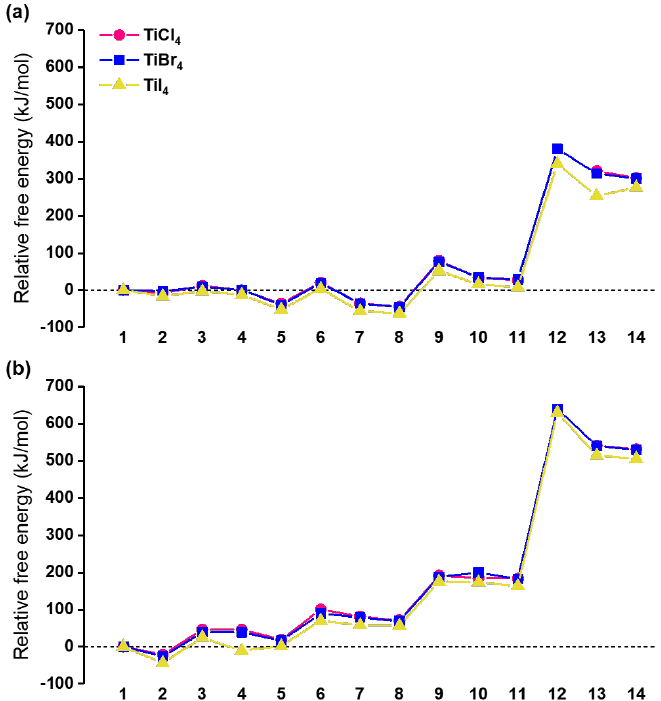
Figure 5. Gibbs free energy change for sequential adsorption of TiX 4 on functionalized Si surface at room temperature: ( a ) –OH functionalized Si surface; and ( b ) –NH 2 functionalized Si surface. (1) Before adsorption; (2) molecular adsorption; (3, 6, 9, and 12) transition states; and (4, 7, 10, and 13) HCl-desorbed chemisorption state.